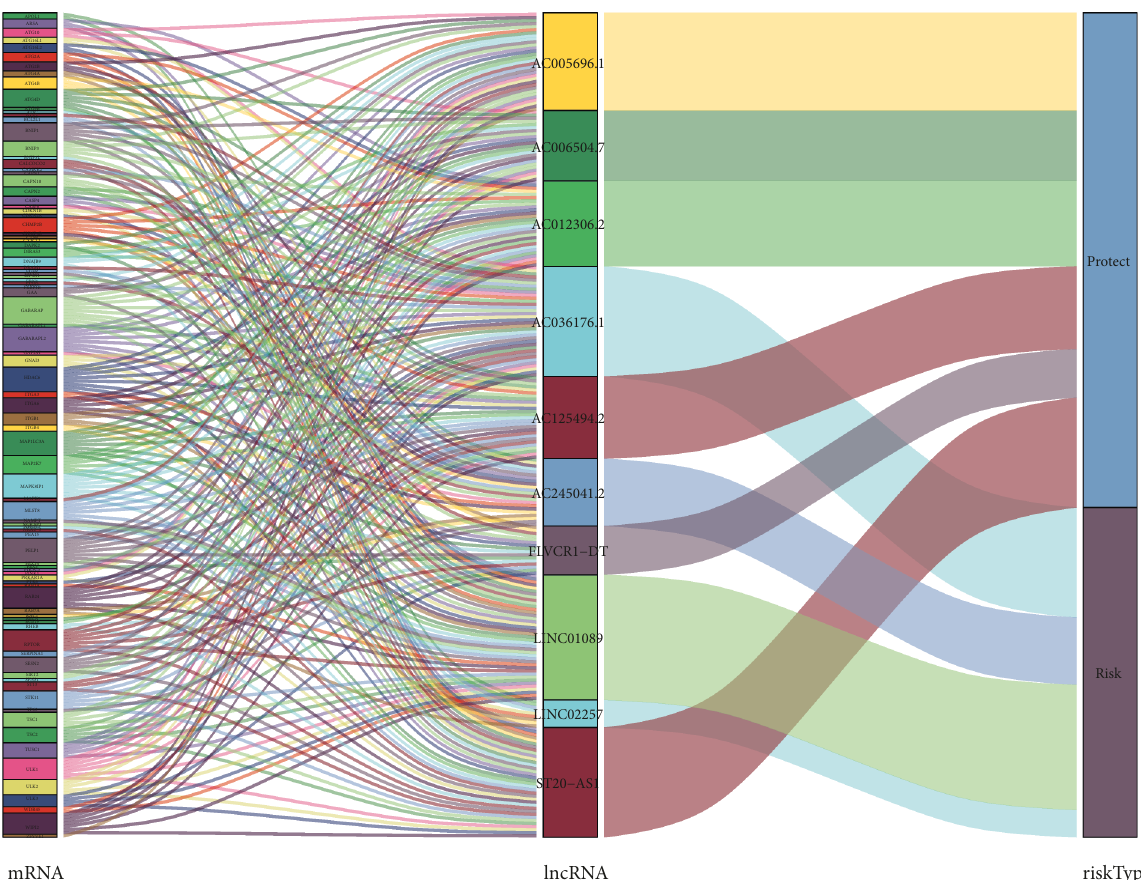
Figure 3: The relationship between autophagy-related genes, independently diagnosed lncRNAs, and risk types was demonstrated in the Sankey